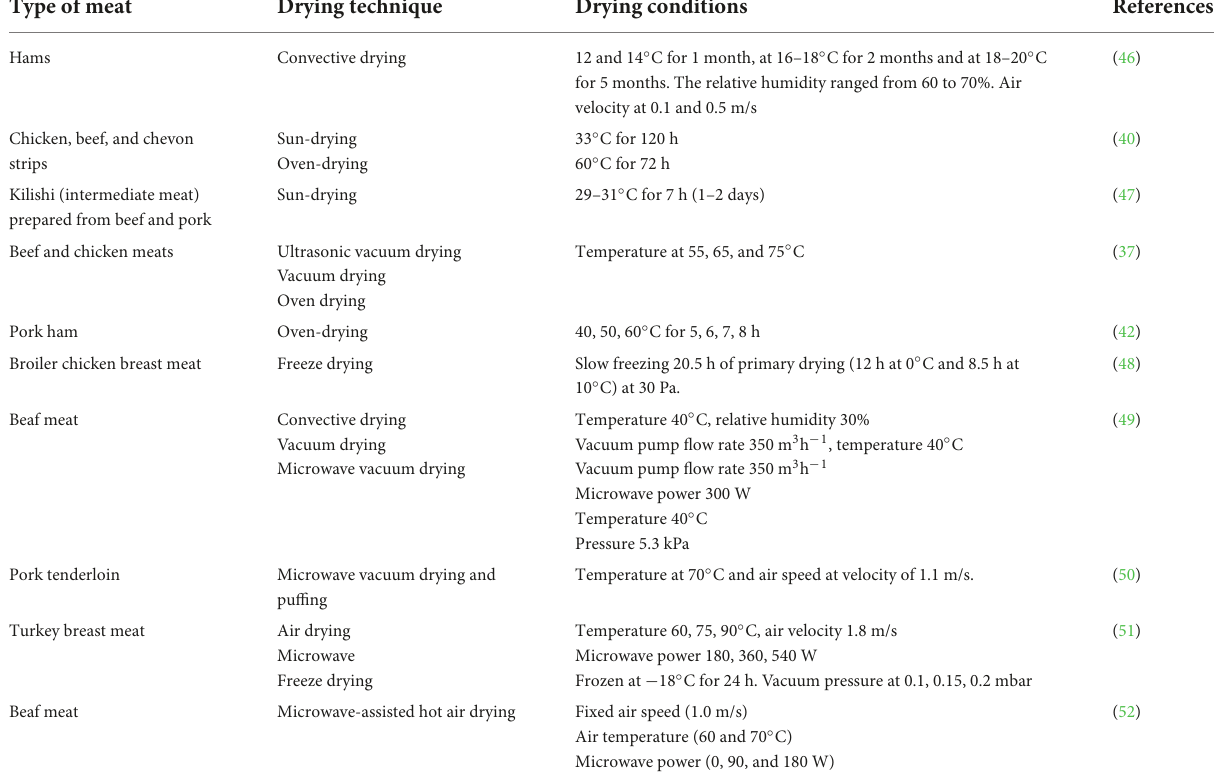
TABLE 2 Different drying techniques with their respective drying